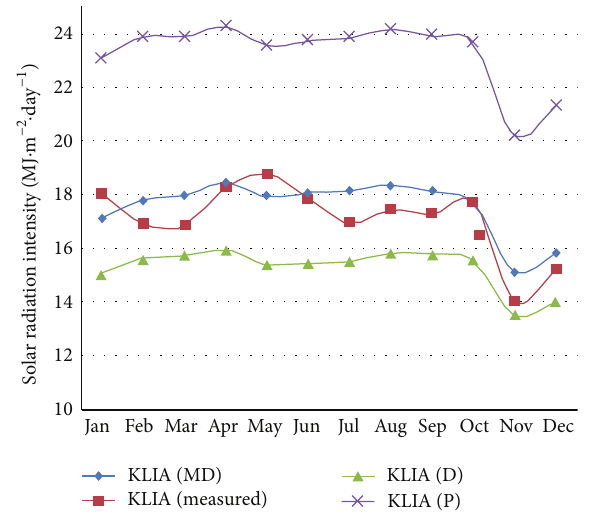
Figure 2: Comparison between three methodologies and measured